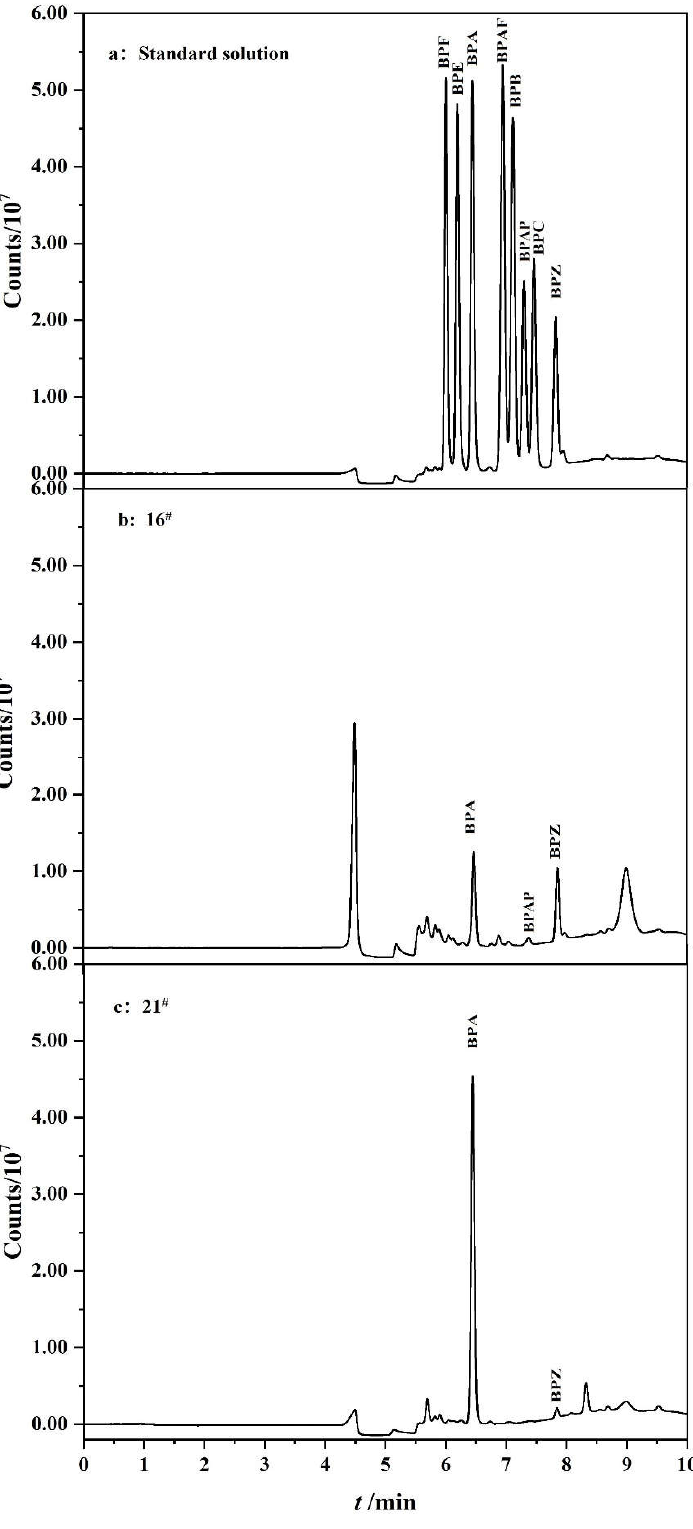
Figure 5. Chromatograms of ( a ) standard solution of eight BPs; ( b ) the extract of 16 # plastic − packaged drinking water; ( c ) the extract of 21 # barreled water.